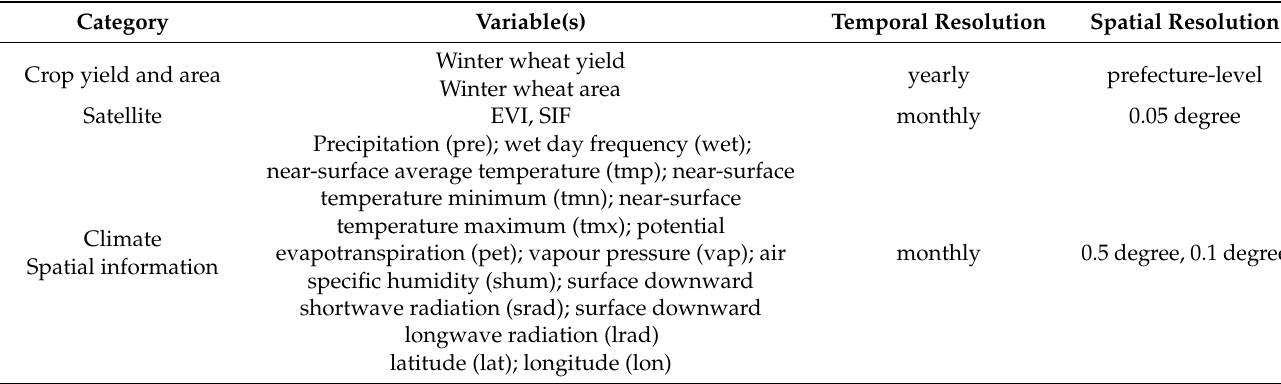
Table 1. Details of